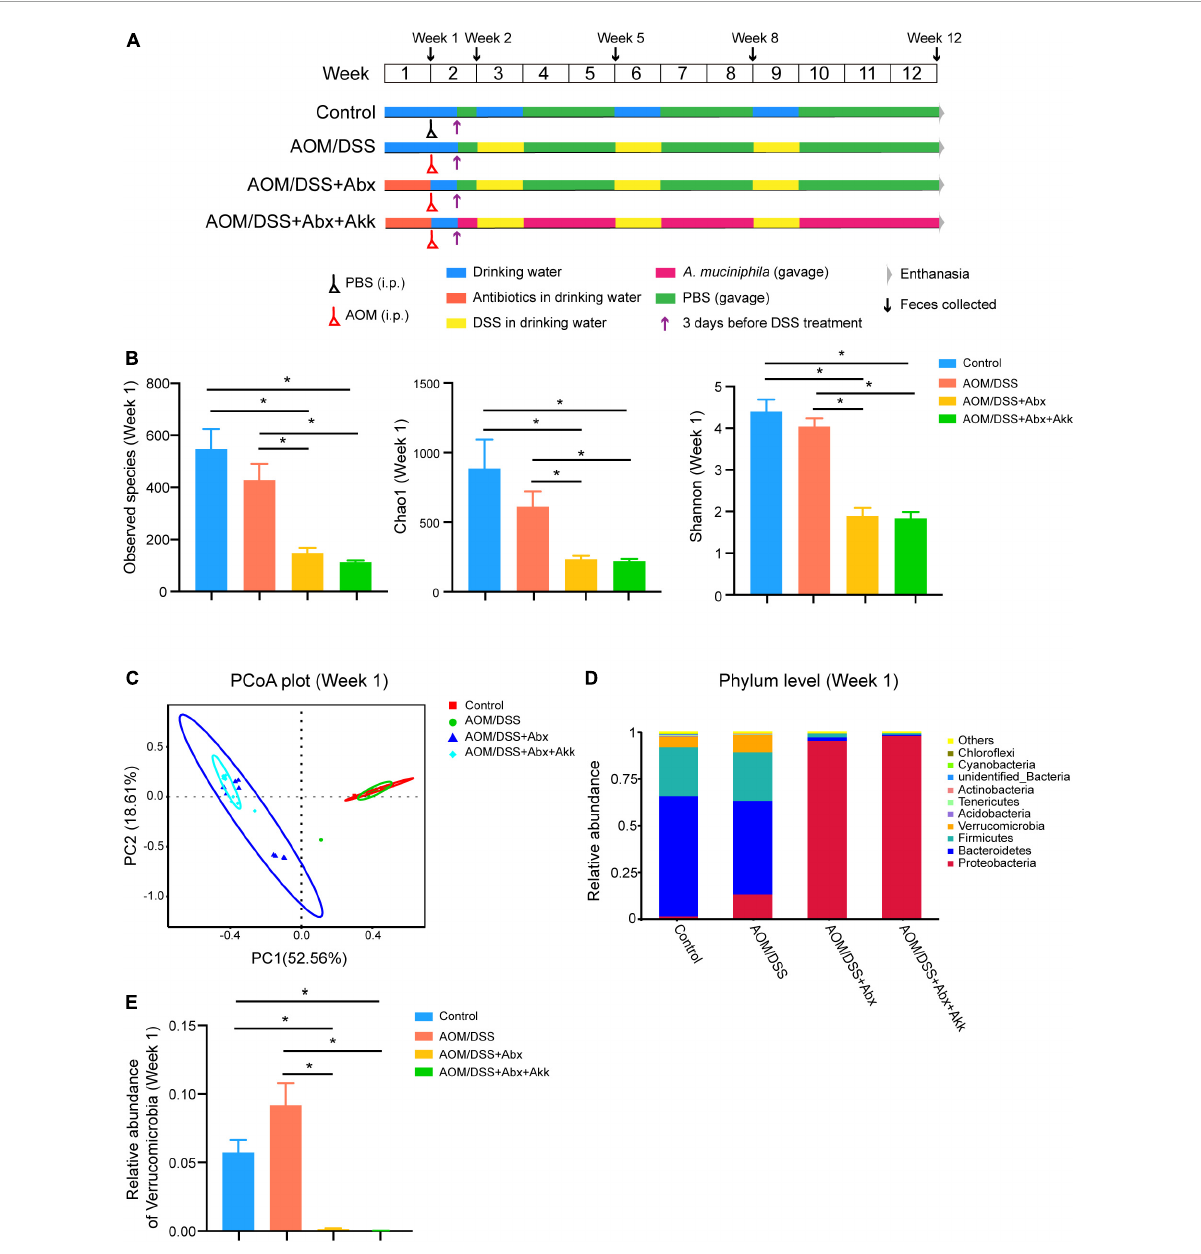
FIGURE1 Antibiotic treatment significantly disrupted the intestinal microbiome. (A) Experimental schema. Control group, normal control mice; AOM/DSS group, AOM/DSS-induced CAC mice; AOM/DSS + Abx group, AOM/DSS-induced CAC mice pretreated with the antibiotic cocktail; AOM/DSS + Abx + Akk group, AOM/DSS-induced CAC mice pretreated with the antibiotic cocktail and further administrated with Akkermansia muciniphila during tumorigenesis. (B) α -Diversity indexes (observed species, Chao1, Shannon) of the gut microbiota among the four groups (week 1). (C) PCoA plot based on Bray-Curtis distance of the four groups (week 1). (D) Relative abundance of the top ten most abundant taxa at the phylum level of the four groups (week 1). (E) Relative abundance of Verrucomicrobia among the four groups (week 1). Data are shown as means ± SEM, * P < 0.05.